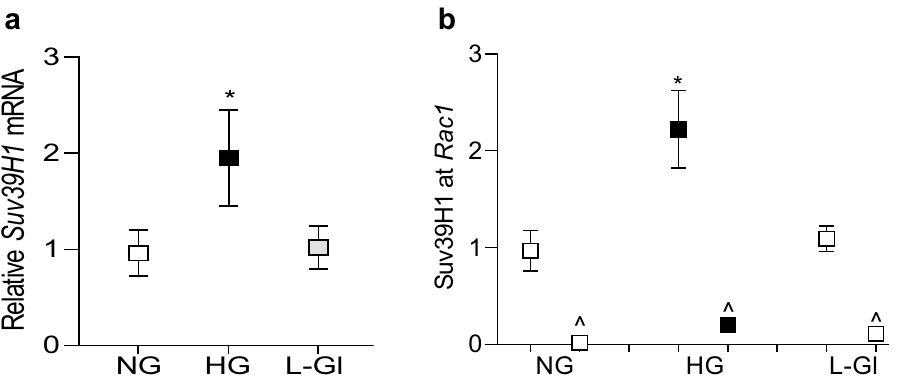
Figure 2. Effect of high glucose on the gene expression of Suv39H1 and its binding at Rac1 promoter. ( a ) Suv39H1 gene transcripts were quantified in HRECs by qRT-PCR using β-actin as a housekeeping gene, and ( b ) binding of Suv39H1 at Rac1 promoter was determined by ChiP technique. The values are represented as mean ± SD of measurements made in duplicate in three or more cell preparations. ^ = IgG antibody and * p < 0.05 vs NG.